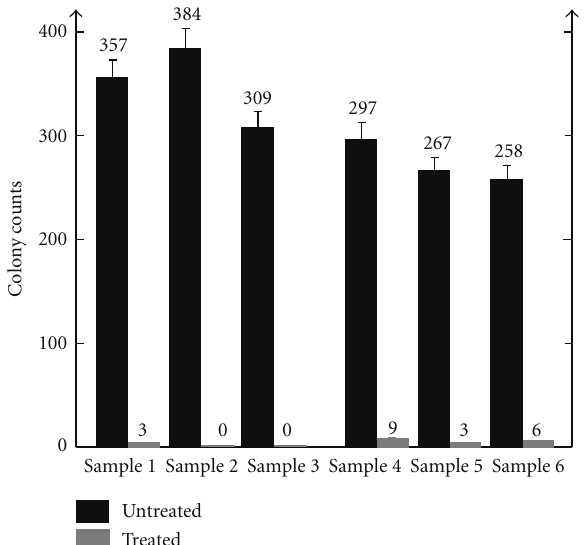
Figure 6: The colony counts of carious lesions (samples 1–3) and root canals (samples